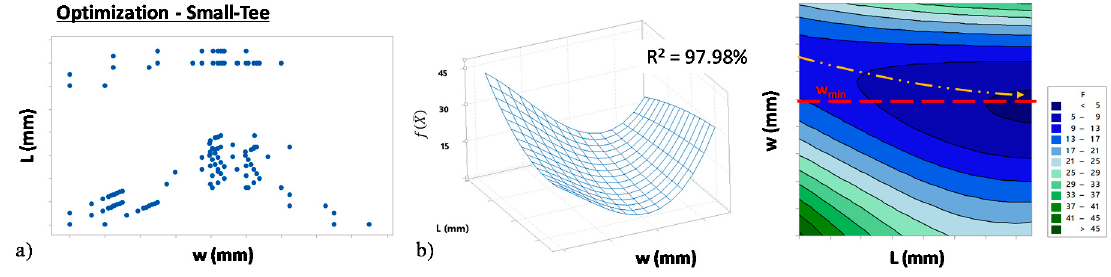
Figure 7. Results of the numerical optimization (Small-Tee). ( a ) Points tested by the algorithm in the (L, w) domain and ( b ) numerical fit of the objective function 𝑓(cid:4666)𝑋(cid:3364)(cid:4667) .